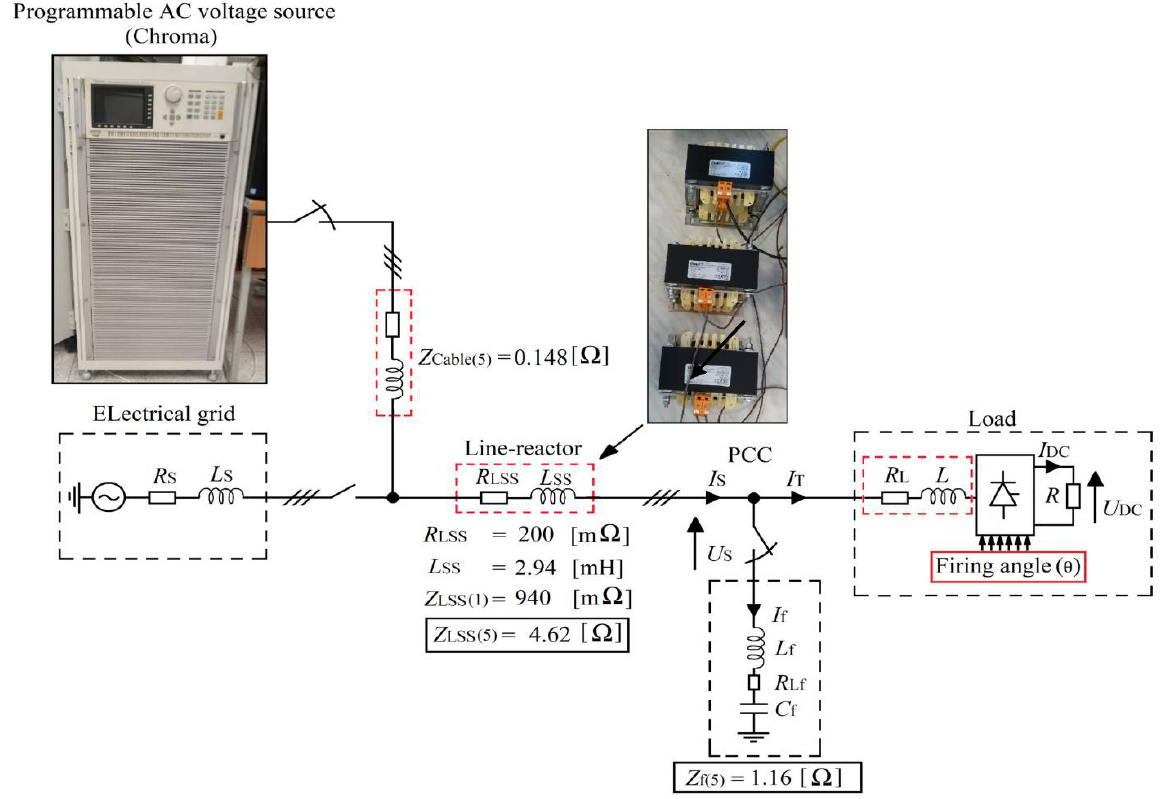
Figure 31. Experiments with the programmable voltage source: equivalent circuit of the laboratory model with the additional line-reactor L SS . The line reactor parameters were measured in the labor- atory.